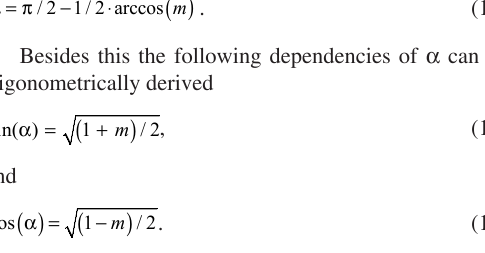
Figure 4b. The total shears obtained by rigid block and slip line analysis are nearly the same at low friction. At the highest friction the total shear derived by the rigid block analysis is only about 0.1 lower then the total shear obtained by the slip line analysis. Thus the difference in shear calculated by two methods is less than 5.5%.